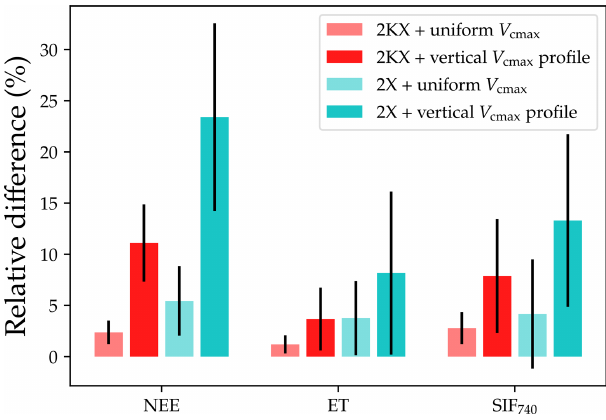
Figure 6. Relative differences between IJKX, 2KX, and 2X for the net ecosystem exchange of CO 2 (NEE), evapotranspiration (ET), and solar-induced chlorophyll fluorescence (SIF 740 ) fluxes. The lighter bars indicate the case with uniform leaf photosynthetic ca- pacity in the canopy. The darker bars indicate the case with a profile of vertical photosynthetic capacity (exponentially decreasing capac- ity in the lower canopy). The bars plot relative differences of the fluxes compared to IJKX (positive value means overestimated flux). Figure 7. Diurnal cycle of carbon and water fluxes using five differ-